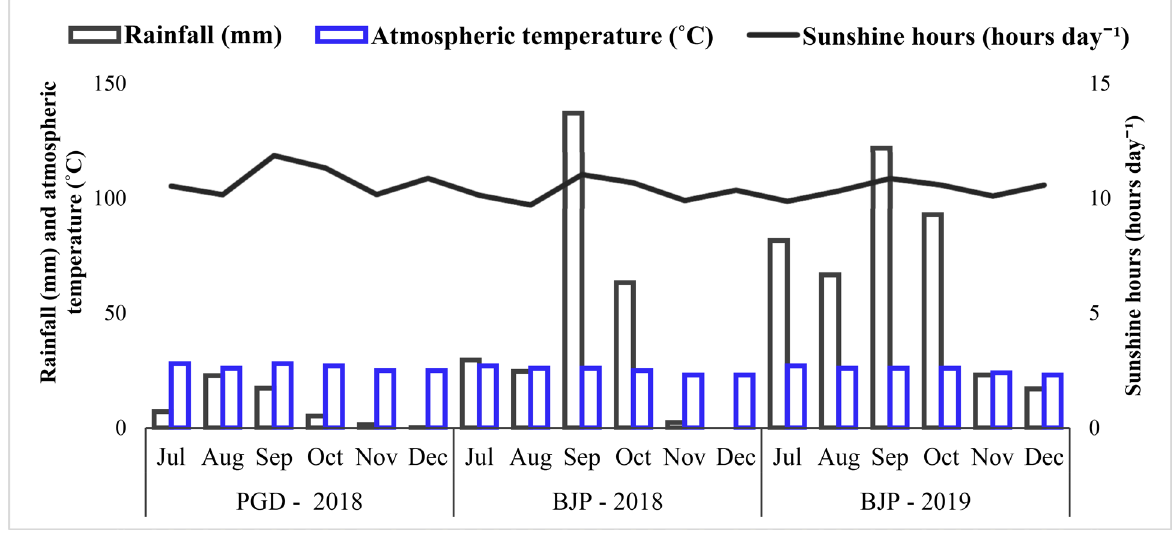
Figure 1. Mean monthly rainfall (mm), atmospheric temperature (°C) and sunshine hours (hours day −1 ) at Pavagada (PGD) during 2018 and Baljigapade (BJP) during 2018 and 2019. The groundnut growing period was early July to early December at all the